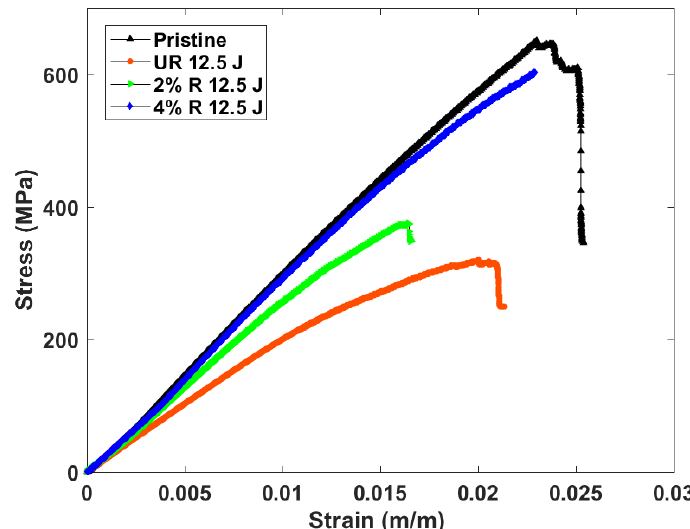
Figure 4. Stress–strain plot of various laminate samples, including an unimpacted neat epoxy sam- ple.